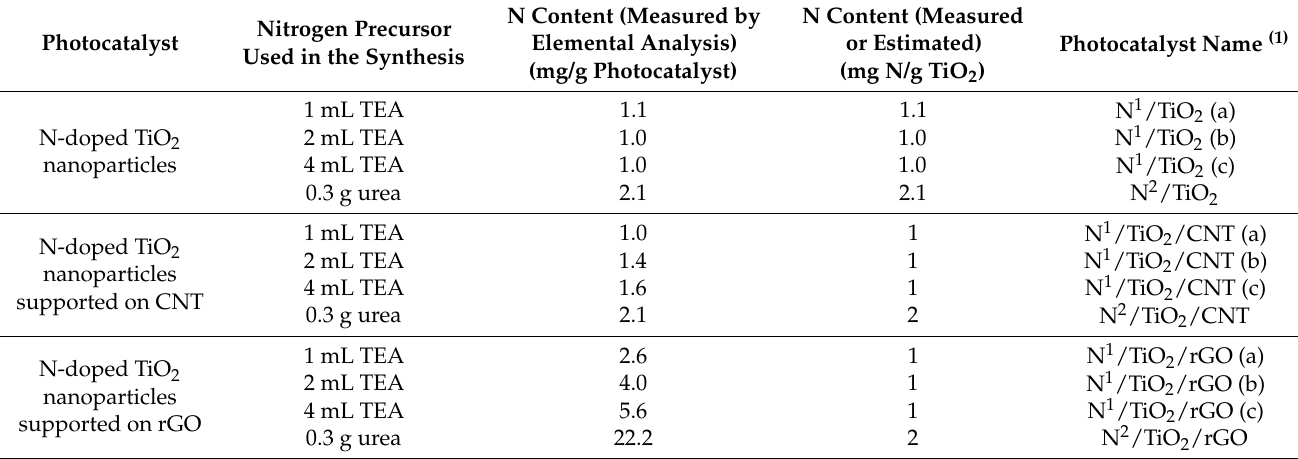
Table 2. N content of the different N-doped